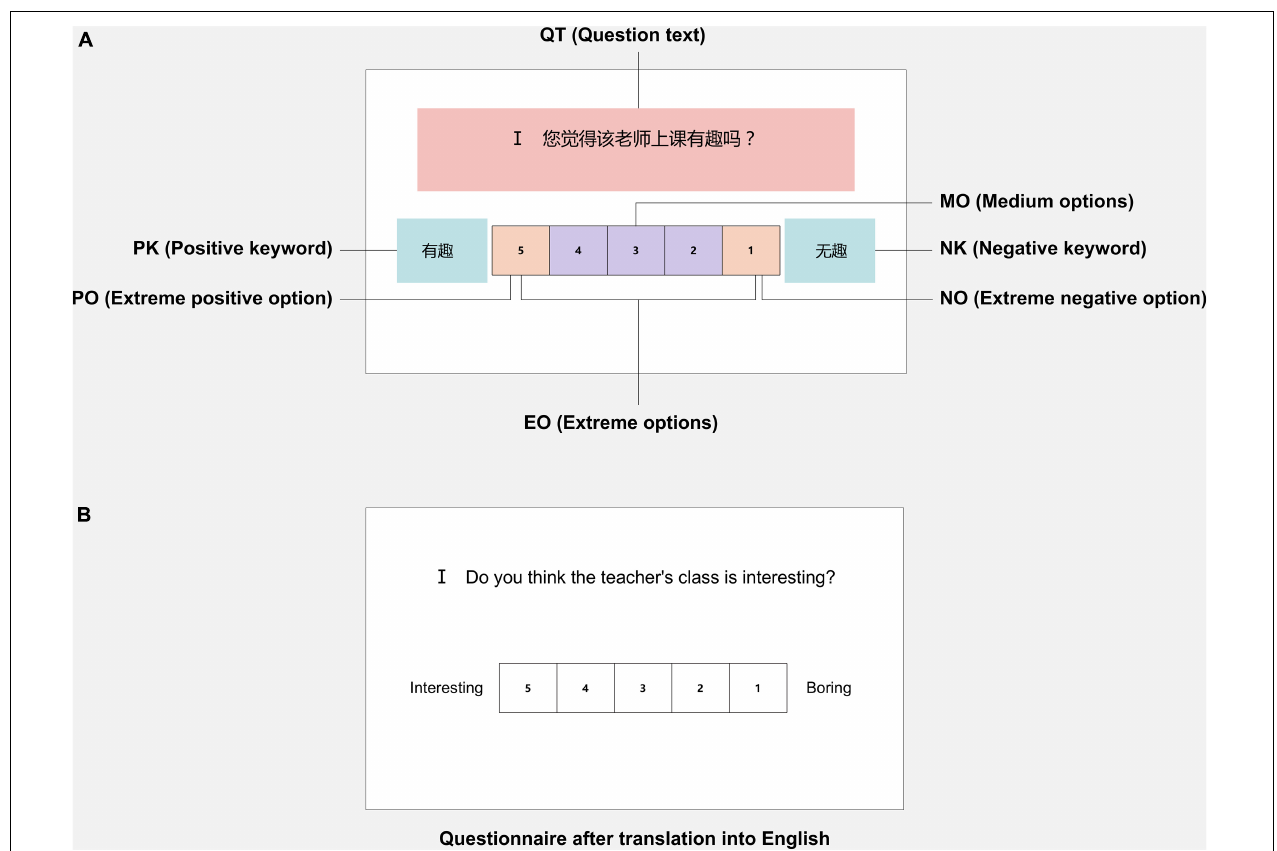
FIGURE 1 | Example of stimuli. (A) Example of the questionnaire with marked AOIs. (B) Example of the questionnaire after translation into English. AOIs, areas of